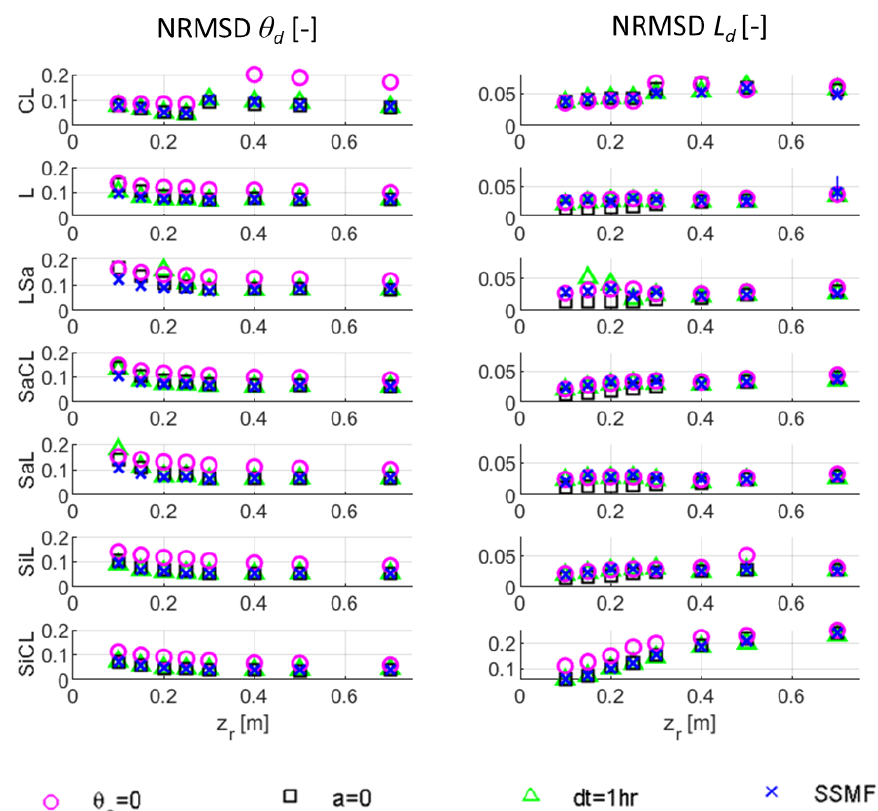
Figure 7. Normalised root mean square deviation (NRMSD) between SSMF and HYDRUS for the daily soil water content θ d (left column) and for the daily vertical flux L d (right column). Simulations are for the eight soil texture profiles: CZO clay loam (CL), loam (L), loamy sand (LSa), sandy clay loam (SaCL), sandy loam (SaL), silt loam (SiL) and silty clay loam (SiCL). The values of the studied depths ( z r ) are on the x-axis; the NRMSD values on the y-axis. The NRMSD values are presented for the simulations from the SSMF (blue crosses), and for the setups where the individual parameters were omitted: θ e = 0 (pink circles), a = 0 (black squares) and dt = 1 h (green triangles).